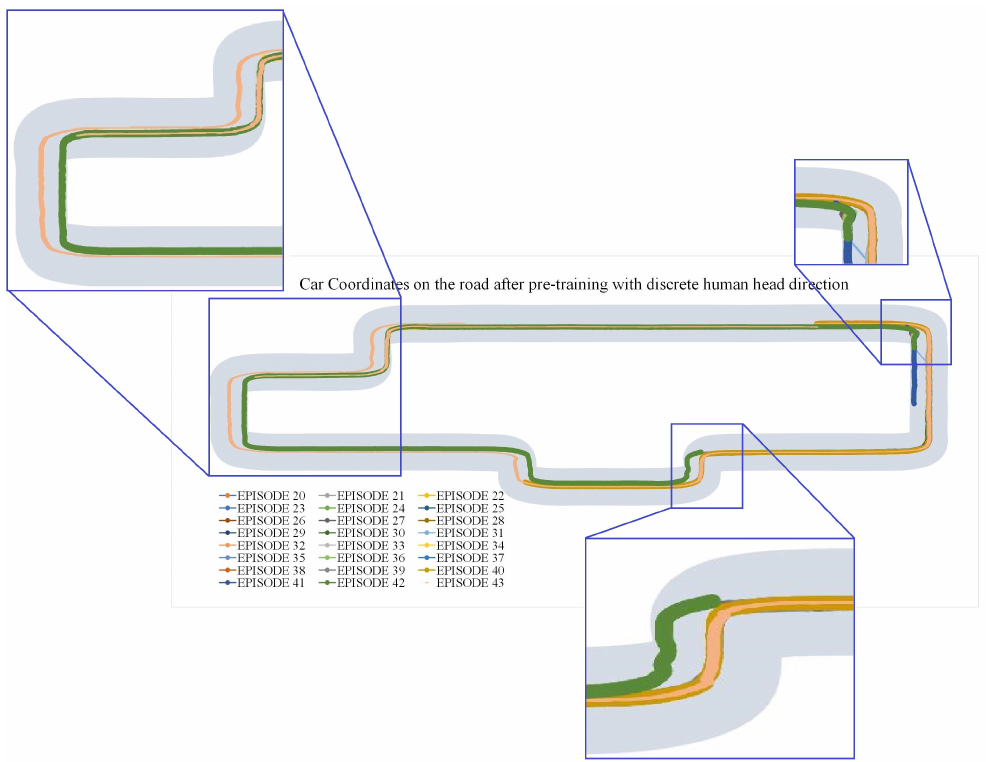
Figure 11. SAC + Discrete Head Direction Feedback: the car’s trajectory on the roadway after pre- training the SAC by 5000 steps of discrete human head direction feedback. Three zoomed-in overlays show the details of some busy parts of the